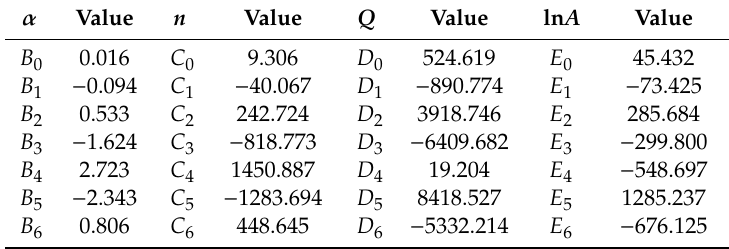
Table 1. The sixth-order polynomial fitting coe ffi cients of each material